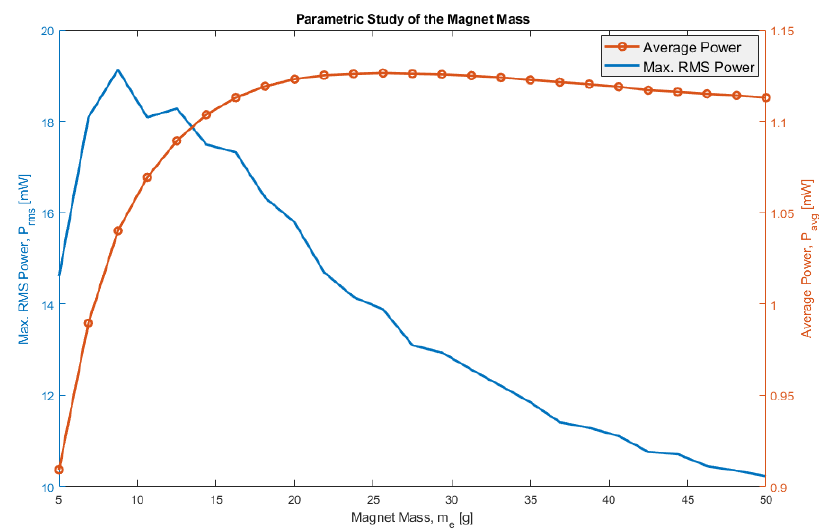
Figure 9. The effect of magnet mass ( m e ) on both the maximum and average power of the harvester.